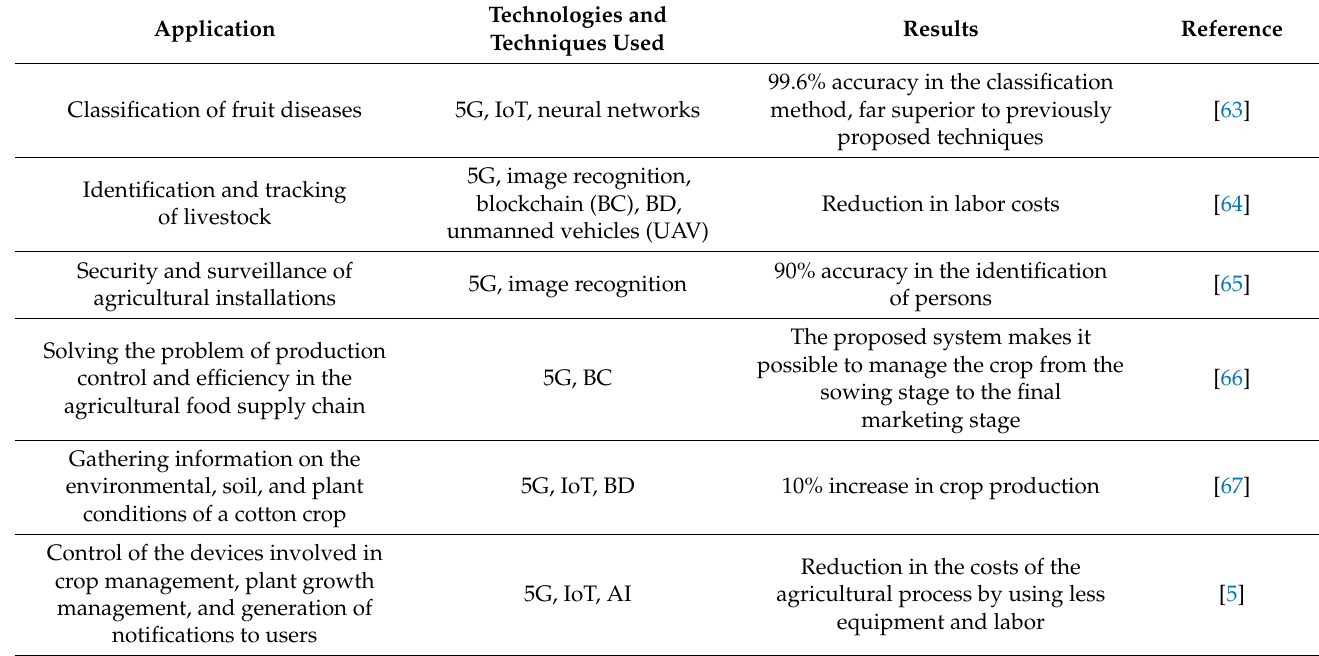
Figure 5. Use cases for agriculture [62]. Table 6. Summary of the results of 5G applications in Table 6. Summary of the results of 5G applications in SF.